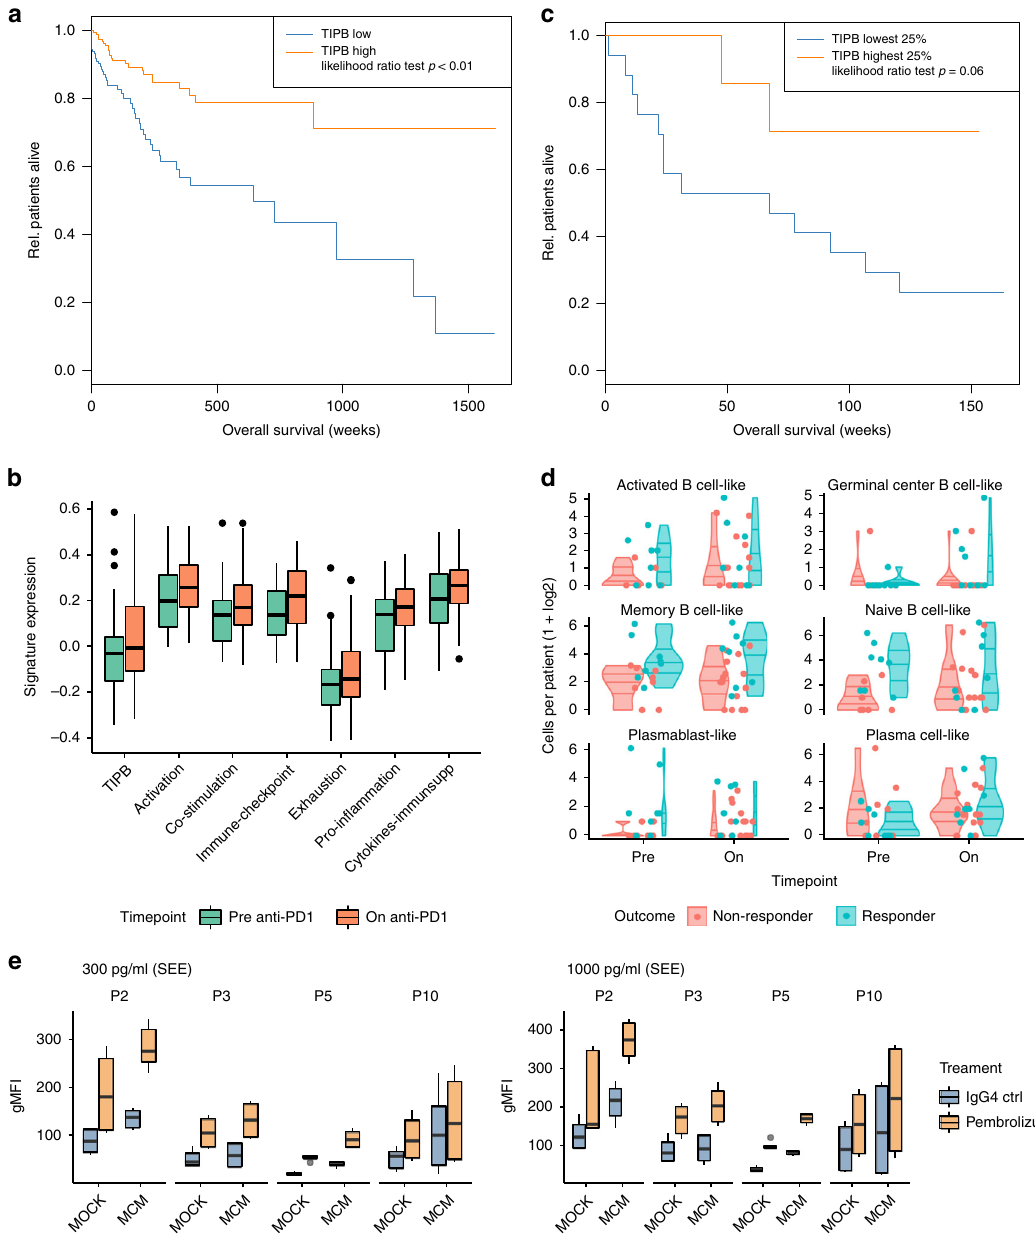
Fig. 4 TIPB predict improved survival of melanoma patients. a Survival analysis of patients expressing high (orange line) or low levels (blue line) of the TIPB signature separated by the median expression in the TCGA melanoma cohort. b Expression of the TIPB signature and all functional signatures before (green boxes) and on (orange boxes) anti-PD-1 therapy as estimated in the Riaz et al. dataset 40 . c Survival analysis based on the TIPB signature in the pre- treatment samples comparing top 25% expressing samples (organe line) against the lower 25% samples (blue line) in the Riaz et al. dataset 40 . d Frequencies of B cell phenotypes (logarithmic scale) before (red) and on (blue) ICB therapy in the scRNA-seq dataset from Sade-Feldman et al. separated by response 29 . Plots represent the relative frequencies, lines represent the 25%, 50%, and 75% quantiles. e NF- ĸ B activity of PD-1-expressing Jurkat T cells co-cultured with control (MOCK) and MCM-conditioned B cells (MCM). Values are shown for control (blue boxes) and Pembrolizumab (orange boxes) treatment. Activation was measured by geo mean fl uorescence intensity (gMFI) after stimulation with 300 pg/ml (left panel) and 1 ng/ml (right panel) Staphylococcus Enterotoxin E (SEE). In all boxplots, lower and upper hinges correspond to the fi rst and third quartiles, center line to the median. Upper whisker extends from the hinge to the largest value no further than 1.5 times the interquartile